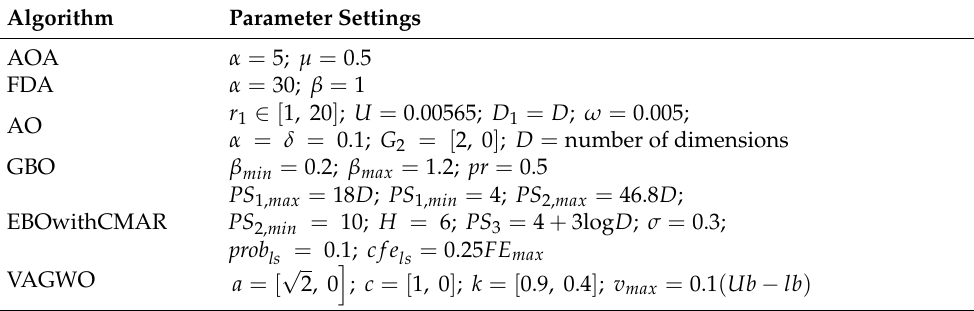
Table 5. Parameter settings of the VAGWO and the newly proposed